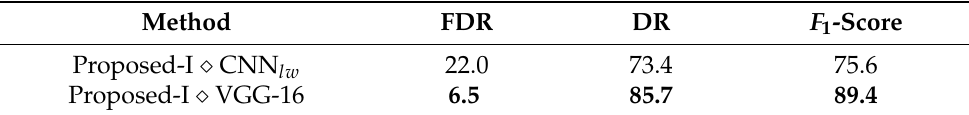
Table 5. The ablation experiment (%) on the testing set for the CNN architecture. X (cid:5) Y indicates that the backbone network of X is Y